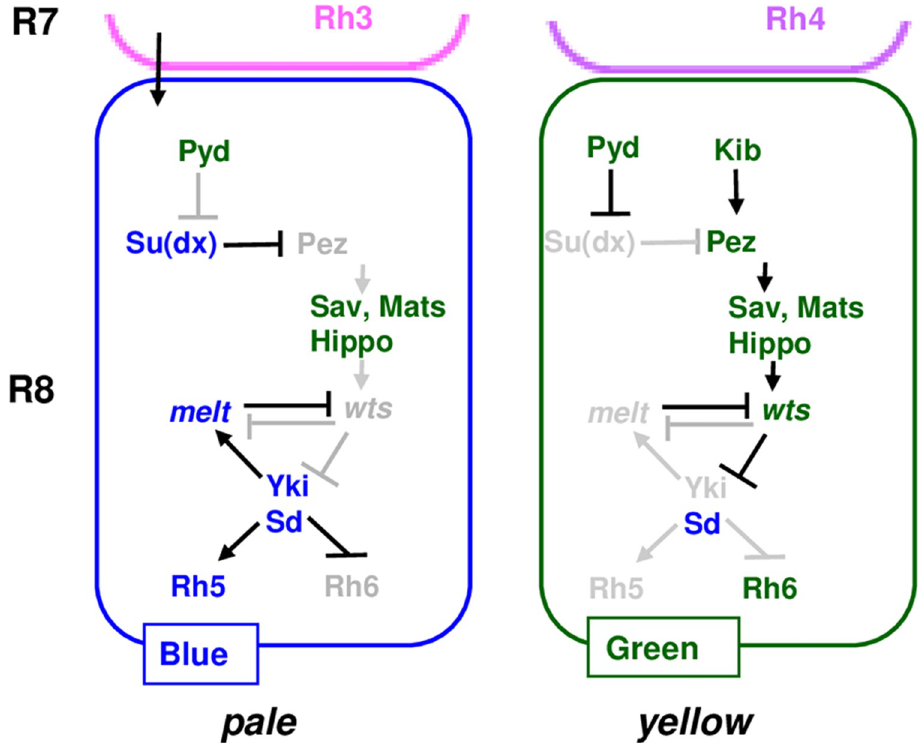
Fig 8. Model: the role of Pyd in R8 subtype fate specification. Pyd represses Su(dx) and may function in parallel to Kib to promote yR8 and repress pR8 subtype fate specification. Pyd may antagonize the Su(dx)-mediated Pez degradation. See Discussion for detail. Genes or proteins that are inactive or not expressed are denoted by grey font, while those that are expressed and/or active are represented by blue, green or black font. Model is based on the data in this study and the previous works